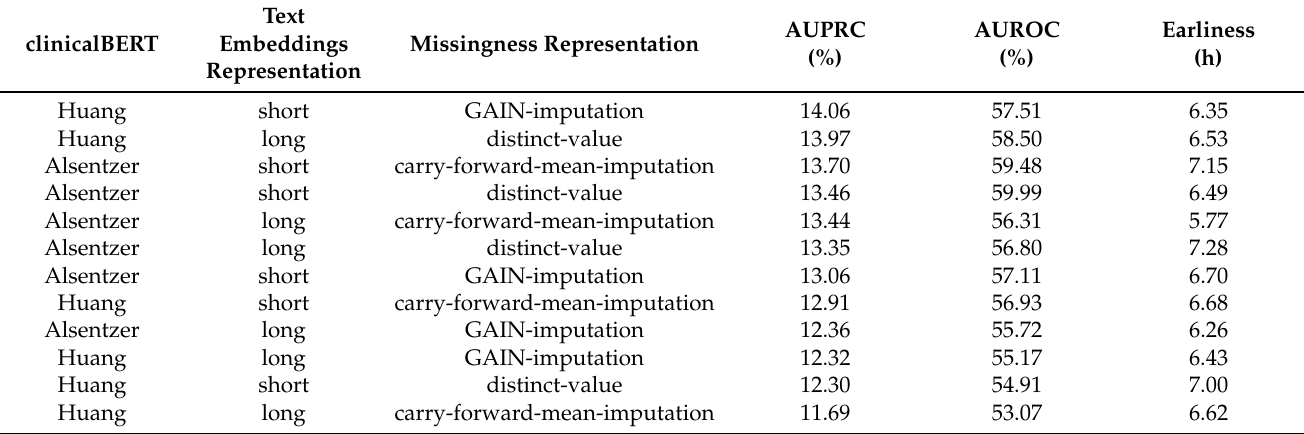
Table 6. Evaluation results using clinical-text input features in single-server